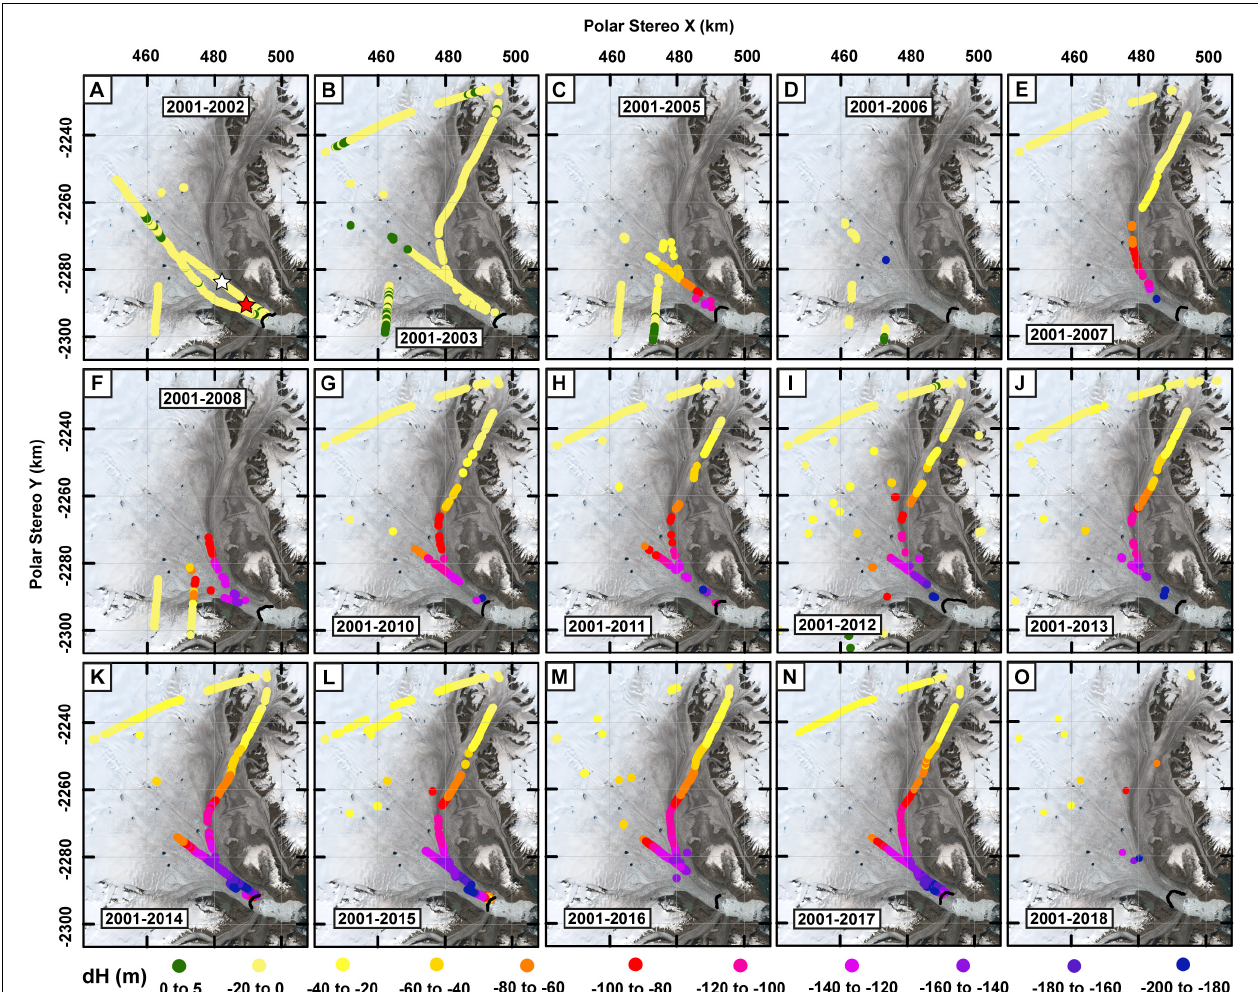
FIGURE 5 | Surface elevation change for Kangerlussuaq relative to 2001 baseline from Operation IceBridge ATM data. Panels relate to surface elevation change for the time periods 2001–2002 (A) , 2001–2003 (B) , 2001–2005 (C) , 2001–2006 (D) , 2001–2007 (E) , 2001–2008 (F) , 2001–2010 (G) , 2001–2011 (H) , 2001–2012 (I)